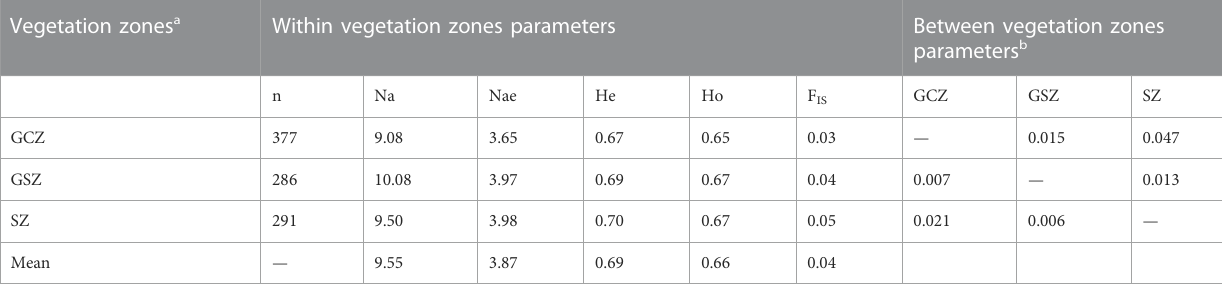
TABLE 3 Genetic diversity parameters of the 954 goats within and among the three vegetation zones of Benin. Vegetation zones a Within vegetation zones